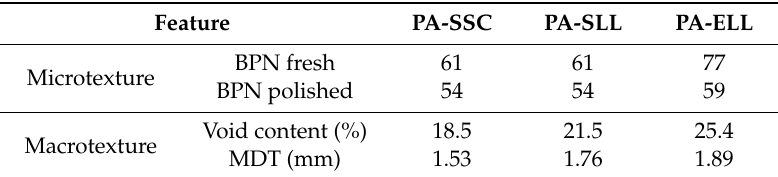
Table 7. Skid Table 7. Skid resistance.